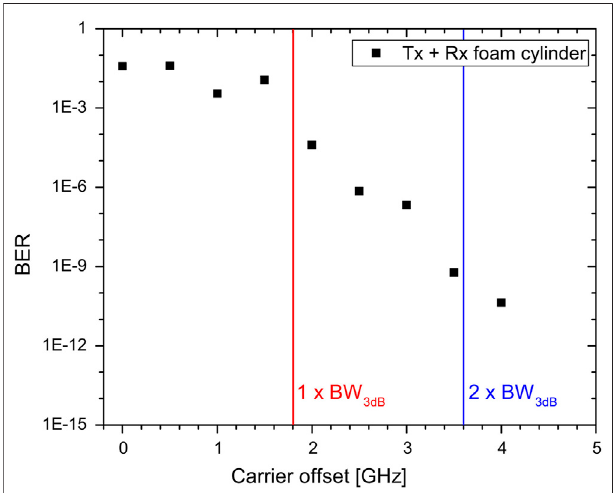
FIGURE 8 | In fl uence of LOS crosstalk on the BER of a wireless data transmission, shown as function of the pitch between two parallel links. Distance between transmitter and receiver is set to 10 cm. Both links are operated at the same carrier frequency [26].